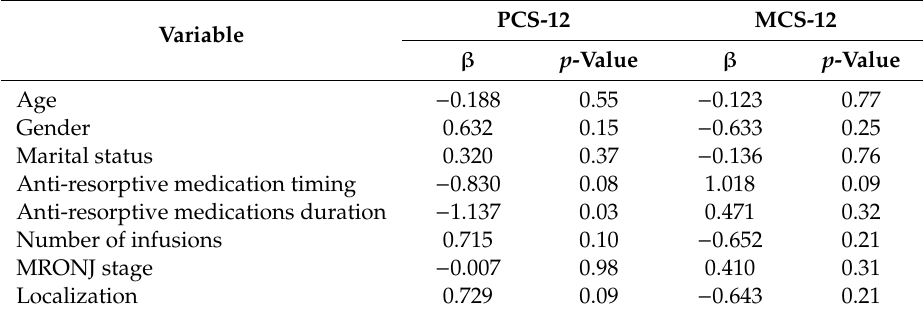
Table 3. Multiple linear regression